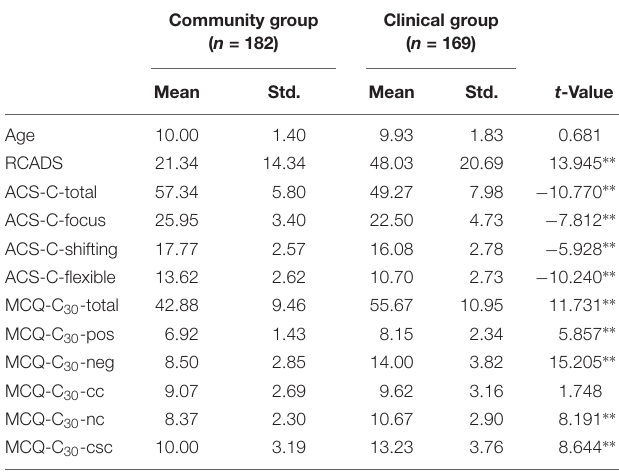
TABLE 1 | Group comparisons between the community- and the clinical group on age, symptom severity (RCADS), attentional control (ACS-C), and metacognitive beliefs (MCQ-C 30 ); mean score, standard deviation and t